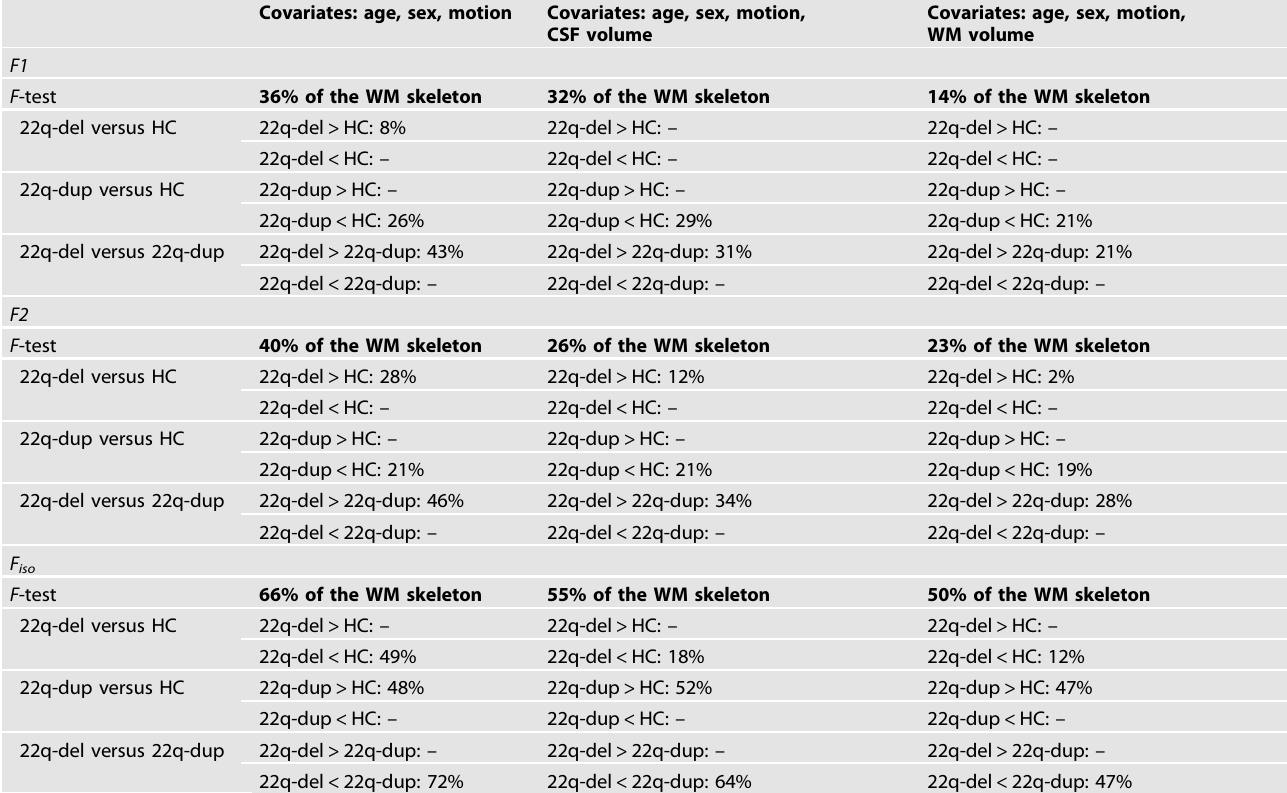
CSF cerebrospinal fl uid, F1 fractional volume of primary fi ber population, F2 fractional volume of secondary fi ber population, F iso fractional volume of the isotropic compartment, HC healthy controls, WM white matter, 22q-del 22q11.2 deletion carriers, 22q-dup 22q11.2 duplication carriers. *All group comparisons were conducted utilizing non-parametric voxel-wise permutation tests for each voxel on the WM skeleton in FSL ’ s Randomize [81]. We tested data against a null distribution generated with 5000 permutations for each contrast using threshold-free cluster enhancement [82] and family wise error correction at a signi fi cance level of p